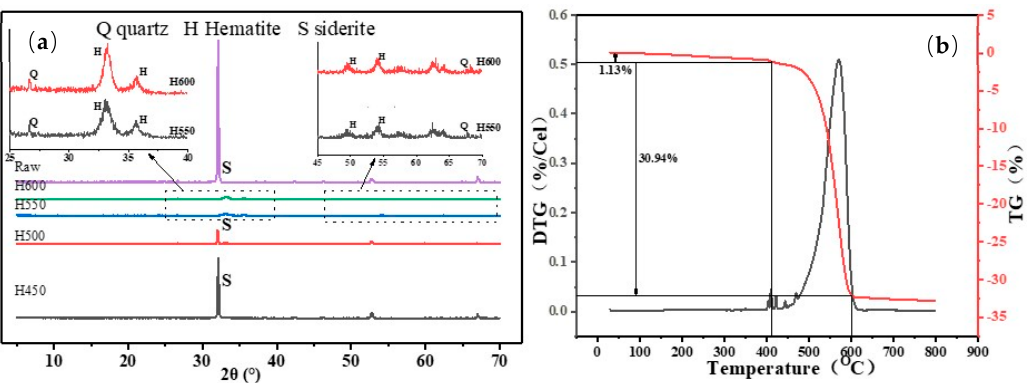
Figure 2. XRD patterns of siderite before and after thermal treatment ( a ); TG and DTG profiles of siderite ( b ).